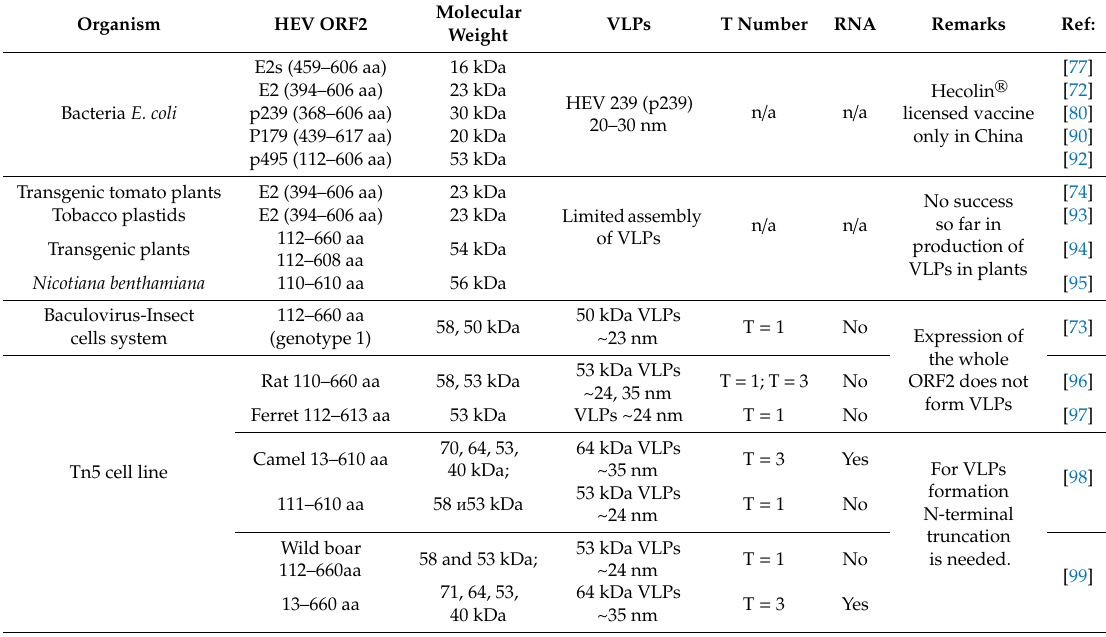
Table 1. Expressed HEV ORF2 protein and VLPs formation in di ff erent